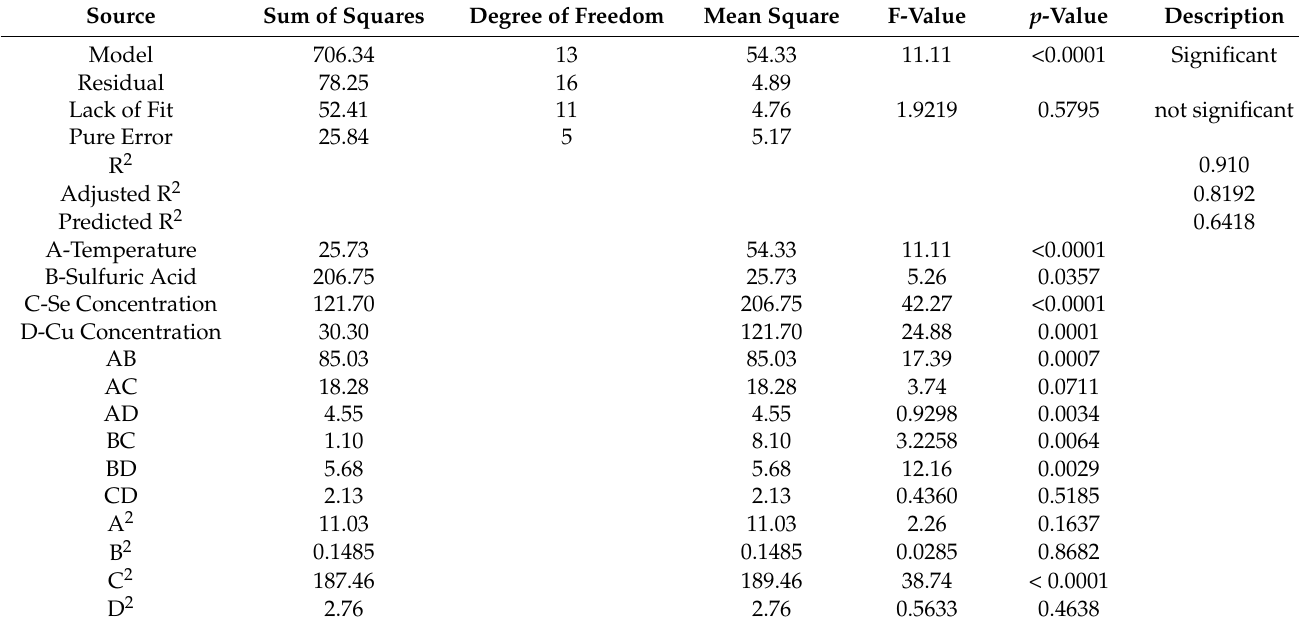
Table 4. Analysis of variance (ANOVA) and coefficient of determination for the suggested quadratic polynomial model for Se.